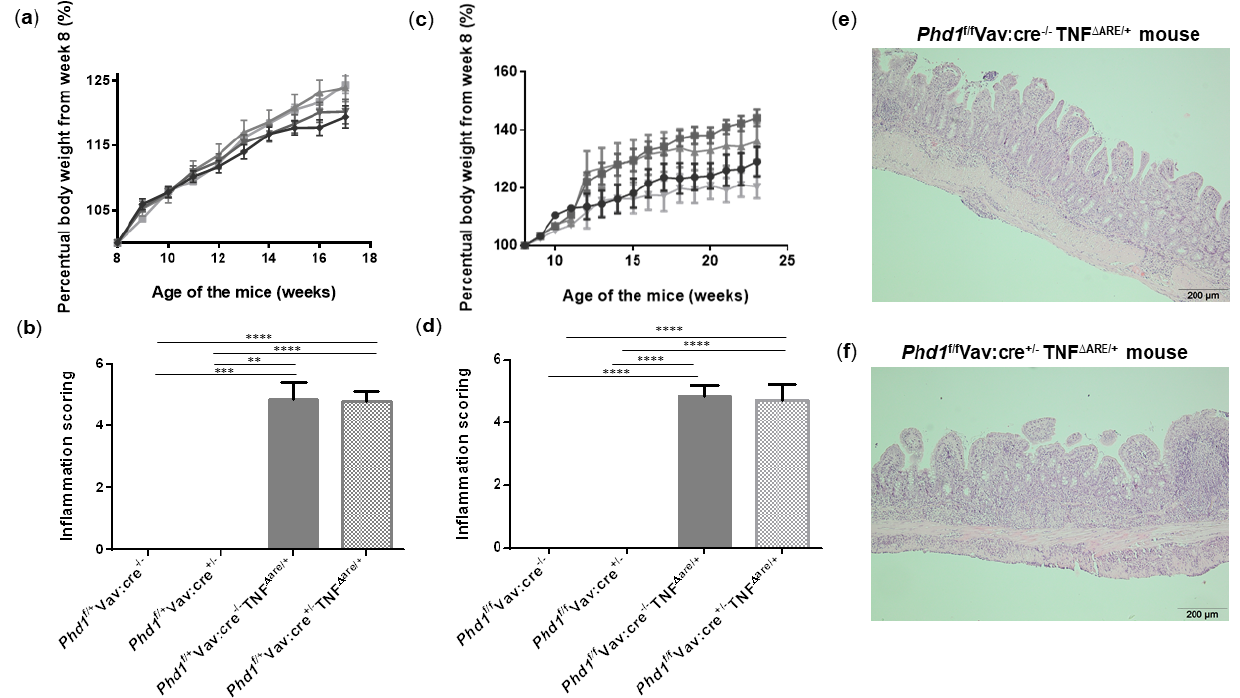
Figure 6. Haematopoietic deletion of Phd1 does not protect against ileitis in TNF Δ ARE/+ mice. ( a ) Percentual body weight evolution from week 8 till 17 of Phd1 f/+ Vav:cre +/ − mice ( ), Phd1 f/+ Vav:cre +/ − TNF ∆ ARE/+ mice ( ), Phd1 f/+ Vav:cre − / − mice ( ) and Phd1 f/+ Vav:cre − / − TNF ∆ ARE/+ mice ( ). ( b ) Total histological inflammation scores of the distal ileum from heterozygous haematopoietic Phd1 floxed mice. ( c ) Percentual body weight evolution from week 8 till 23 of Phd1 f/f Vav:cre +/ − mice ( ), Phd1 f/f Vav:cre +/ − TNF ∆ ARE/+ mice ( ), Phd1 f/f Vav:cre − / − mice ( ) and Phd1 f/f Vav:cre − / − TNF ∆ ARE/+ mice ( ). ( d ) Total histological inflammation scores of the distal ileum from homozygous haematopoietic Phd1 floxed mice. Representative H&E-stained ileal sections from ( e ) a Phd1 f/f Vav:cre − / − TNF ∆ ARE/+ and ( f ) a Phd1 f/f Vav:cre +/ − TNF ∆ ARE/+ mouse. ** p < 0.01, *** p < 0.001, **** p < 0.0001. Data are represented as the mean ± SEM. Since TNF Δ ARE/+ mice exhibit increased numbers of ileal mononuclear phagocytes, neutrophils and elevated proinflammatory cytokine/chemokine expression, we next as- sessed whether these parameters were impacted after Phd1-deletion. As expected and in accordance with the results from above, serum CCL2 ( p = 0.026) and the mRNA expression of Cd11c ( p = 0.031), Ly6g ( p = 0.006), Tnf ( p = 0.035), Ccl2 ( p = 0.003) and Il1 β ( p = 0.031) was significantly higher in the distal ileum of Phd1 f/f Vav:cre − / − TNF Δ ARE/+ mice compared with Phd1 floxed WT controls. The expression of Cd103 was not significantly altered. No significant differences in immune cell nor proinflammatory gene expression profile could